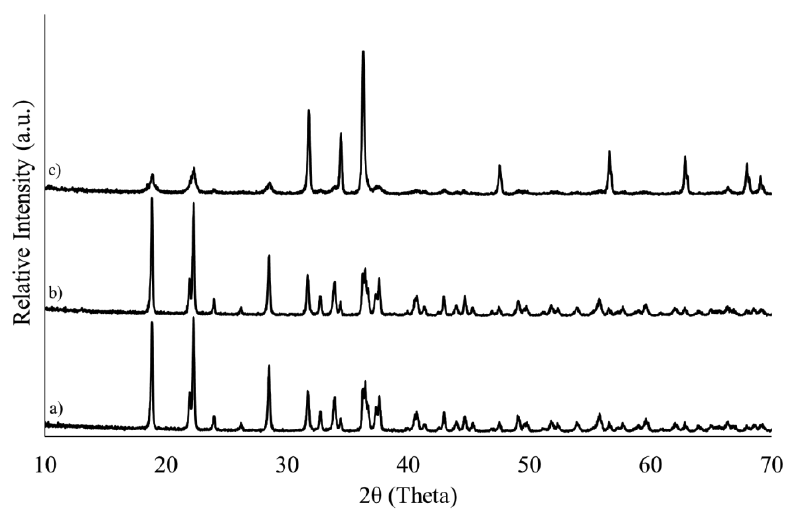
Figure 3: XRD pattern of solid product obtained at: a) 110°C-5 h, b) 120°C-5 h, and c) 110°C-4 h.